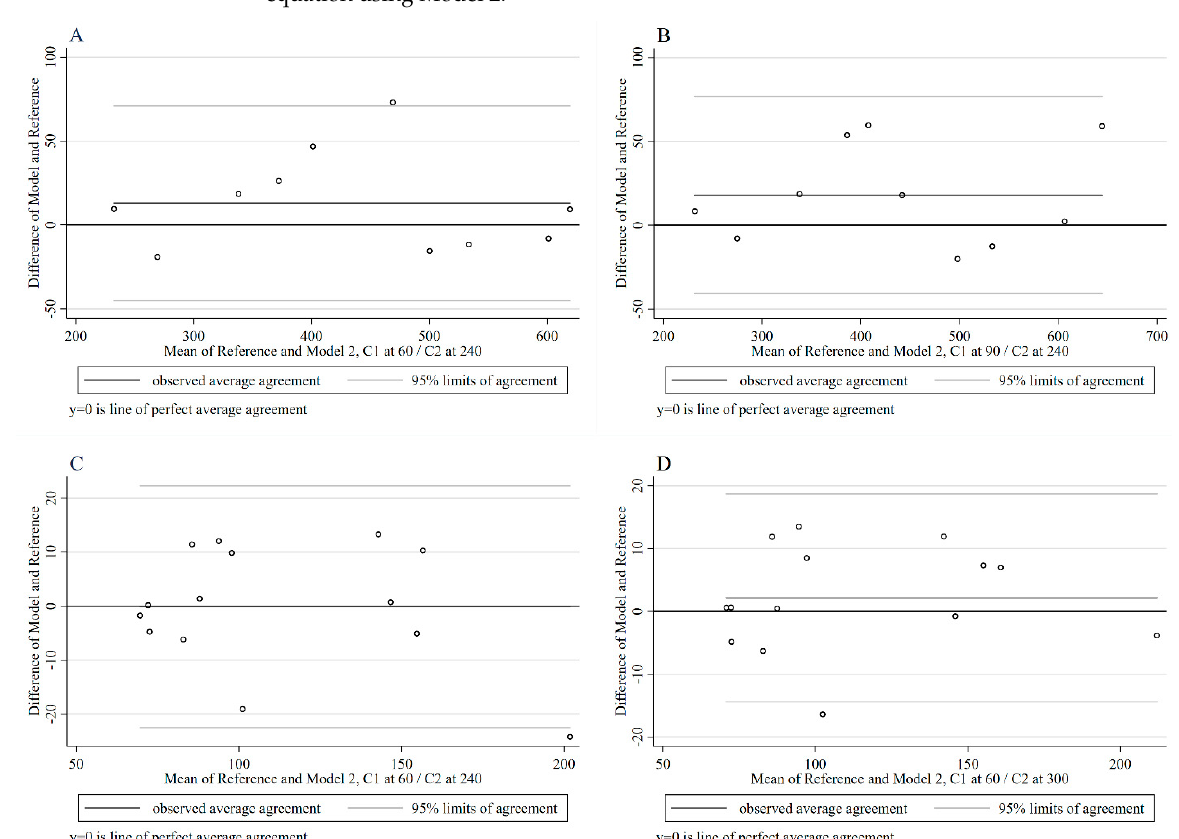
Figure 2. Bland-Altman plots of the reference standard and each selected equation-paired concentra- tion time points combination. ( A ) Adult data set using Model 2 with C1 at 60 min and C2 at 240 after the completed infusion had mean bias of 13.0 (3.0%) and 95% limits of agreement of − 45.0 to 70.9. ( B ) Adult data set using Model 2 with C1 at 90 min and C2 at 240 after the completed infusion had mean bias of 18.0 (4.1%) and 95% limits of agreement of − 40.8 to 76.7. ( C ) Pediatric data set using Model 2 with C1 at 60 min and C2 at 240 after the completed infusion had bias of − 0.1 ( − 0.1%) and 95% limits of agreement of − 22.6 to 22.3. ( D ) Pediatric data set using Model 2 with C1 at 60 min and C2 at 300 after the completed infusion had bias of 2.1 (1.9%) and 95% limits of agreement of − 14.4 to 18.7. The pooled data available from Model 2 with C 1 sampled from 60 to 90 min, and C 2 from 240 to 300 min after the completed infusion, showed a strong correlation